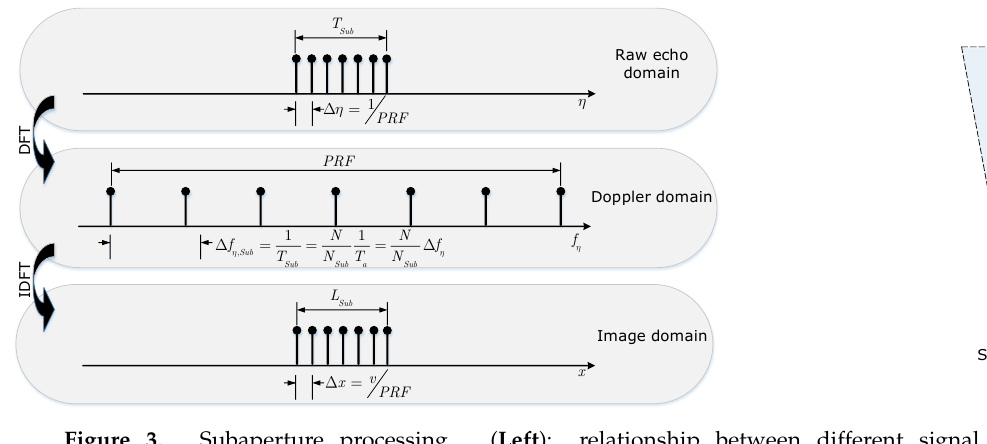
Figure 3. Subaperture processing. ( Left ): relationship between different signal spaces; ( Right ): subaperture observation geometry; in this case, there is no ambiguity free area.